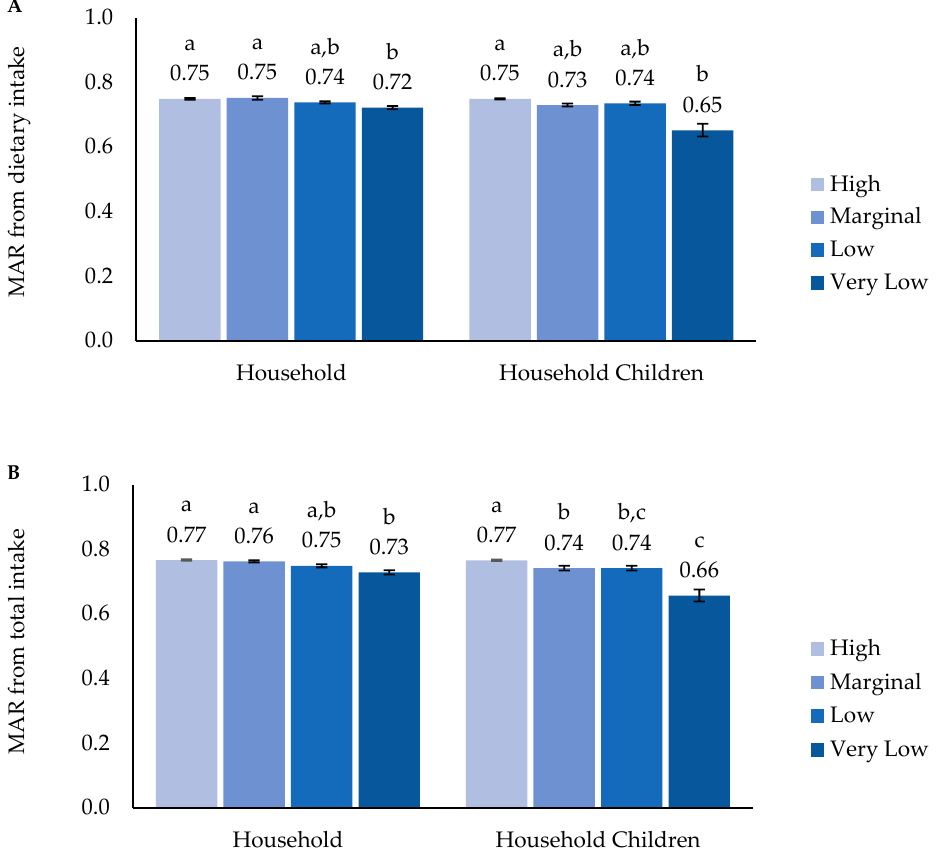
Figure 3. Mean Adequacy Ratio (MAR) from ( A ) dietary-nutrient intake and ( B ) total nutrient intake of U.S. children (2–17 years) by household food security and food security among household children. MAR was calculated from intakes of vitamins A, C, D, and E, folate, calcium, magnesium, iron, and potassium. Estimates with different alphabet letters are significantly different based on pairwise t- tests within each scale at p -value < 0.05. Table 2. Agreement between household food security and food security among household children among U.S. children (2–17 years) 1 .